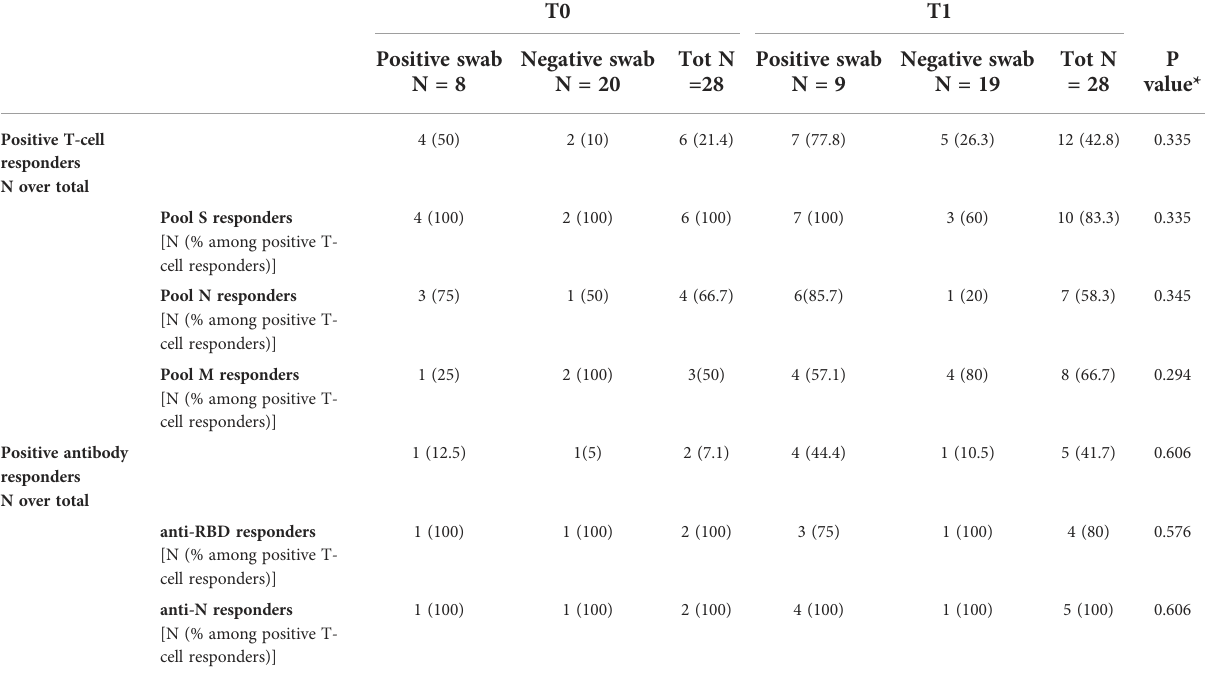
TABLE 4 T-cell and antibody responses in household contacts of COVID-19 patients evaluated at both time points (T0 and T1).